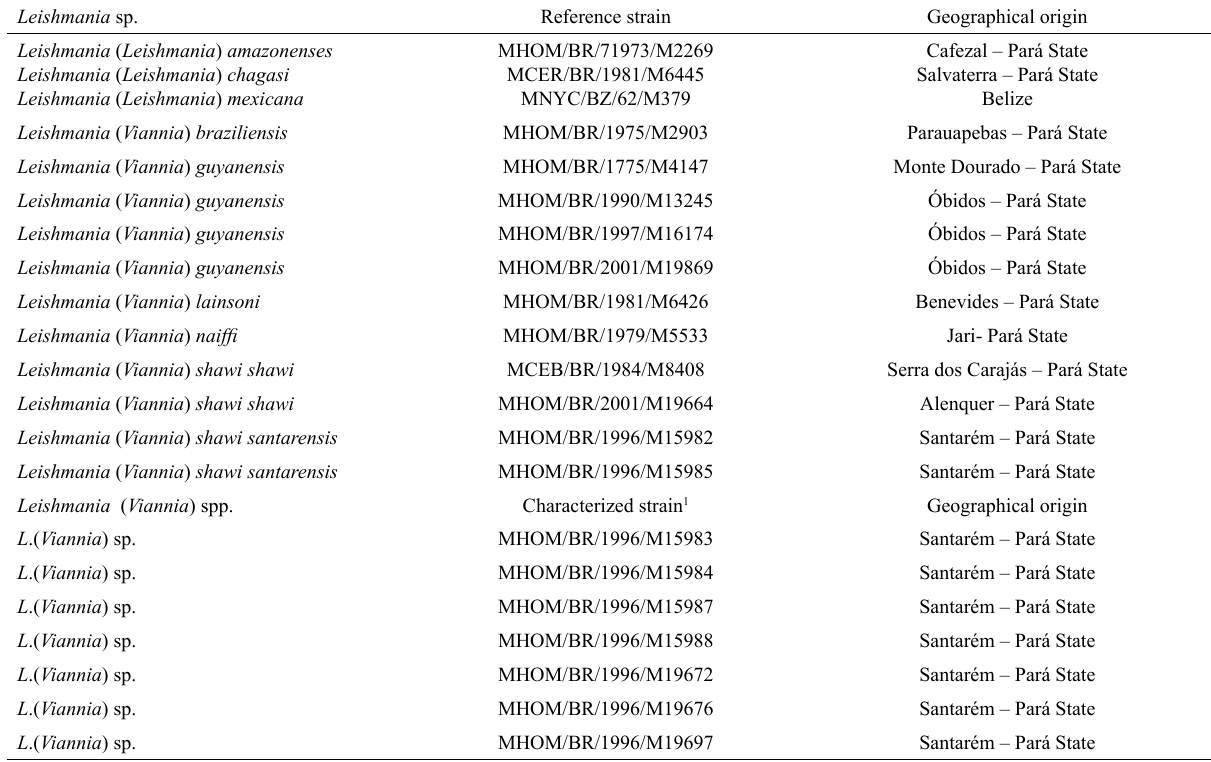
Table 1 – Leishmania strains used in this study. Leishmania